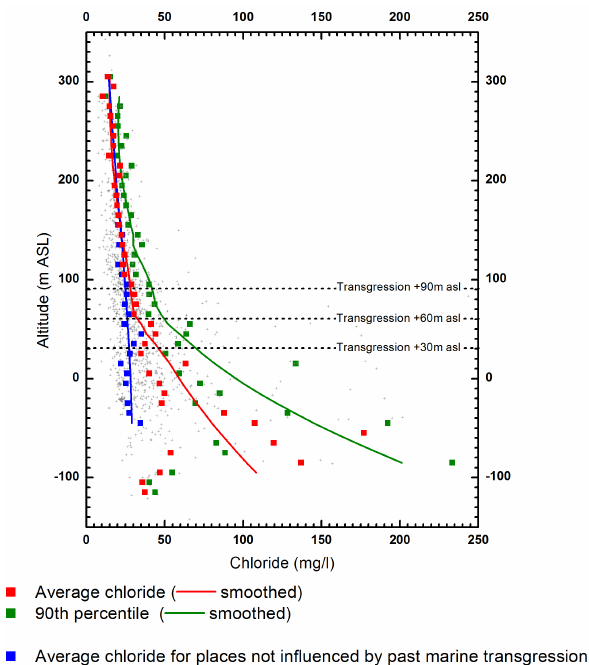
Figure 6. Chloride concentrations versus altitude of well